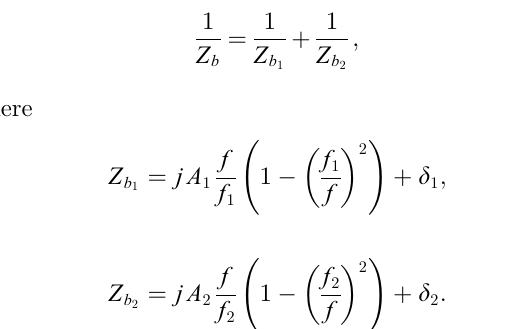
Figure 7. Dimensionless ratio between the velocities v M v M 2 and the pressure on the plate along the